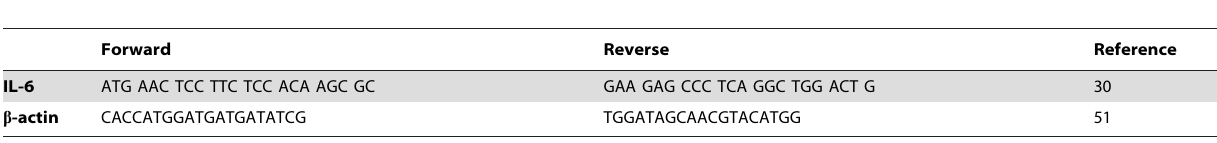
Table 1. Sequence of the IL-6 and b -actin primers used in the study.